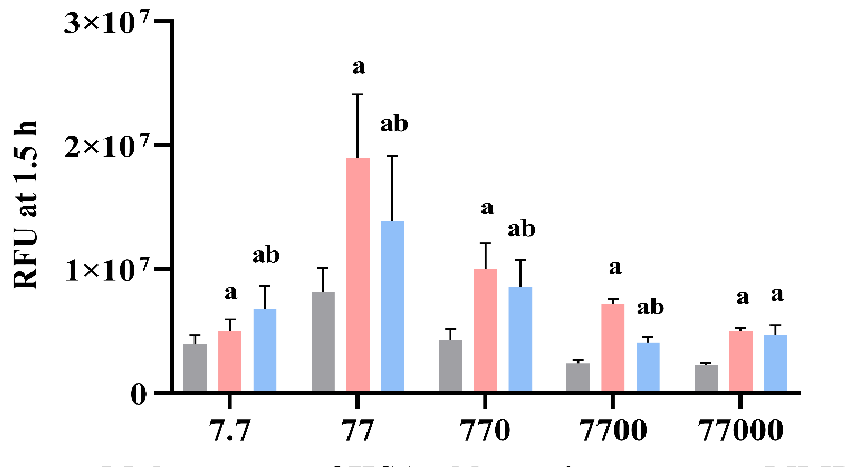
Figure 9. Effect of HSA chloramines on the activation of proMMP9 as determined by fluorescence assay. Chloramines were generated on HSA (40 µ M) exposed to a 50-fold molar excess of HOCl (2 mM), with chloramine formation and concentration determined using the TNB assay. Defined molar excesses of the preformed chloramines (as indicated; pink bars), or chloramine solutions treated with 1 mM Met for 5 min (blue bars), or comparable concentrations of parent protein (gray bars) were then incubated with proMMP9 (13 nM) for 24 h at 37 ◦ C before the determination of the extent of the cleavage of the profluorescent peptide substrate by fluorescence spectroscopy. Data are presented as RFUs and are means ± SDs of three technical replicates from three biological replicates. Statistical analysis was performed using one-way ANOVA with Tukey’s multiple comparisons test. Statistical significance compared with the HSA control is indicated by a, and differences relative to the chloramine-treated samples are indicated by